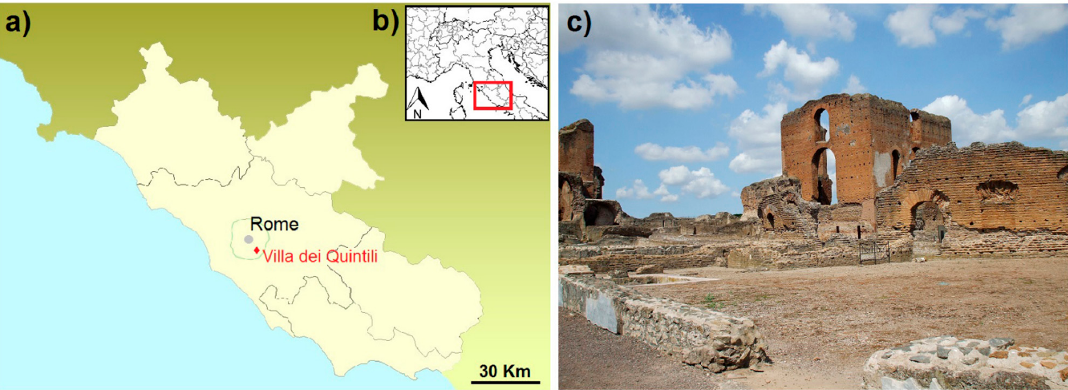
Figure 1. Location of Rome, showing the position of Villa dei Quintili (Rome, Italy) in ( a ) the Lazio region and ( b ) Italy, and ( c ) view of some archaeological ruins of Villa dei Quintili.